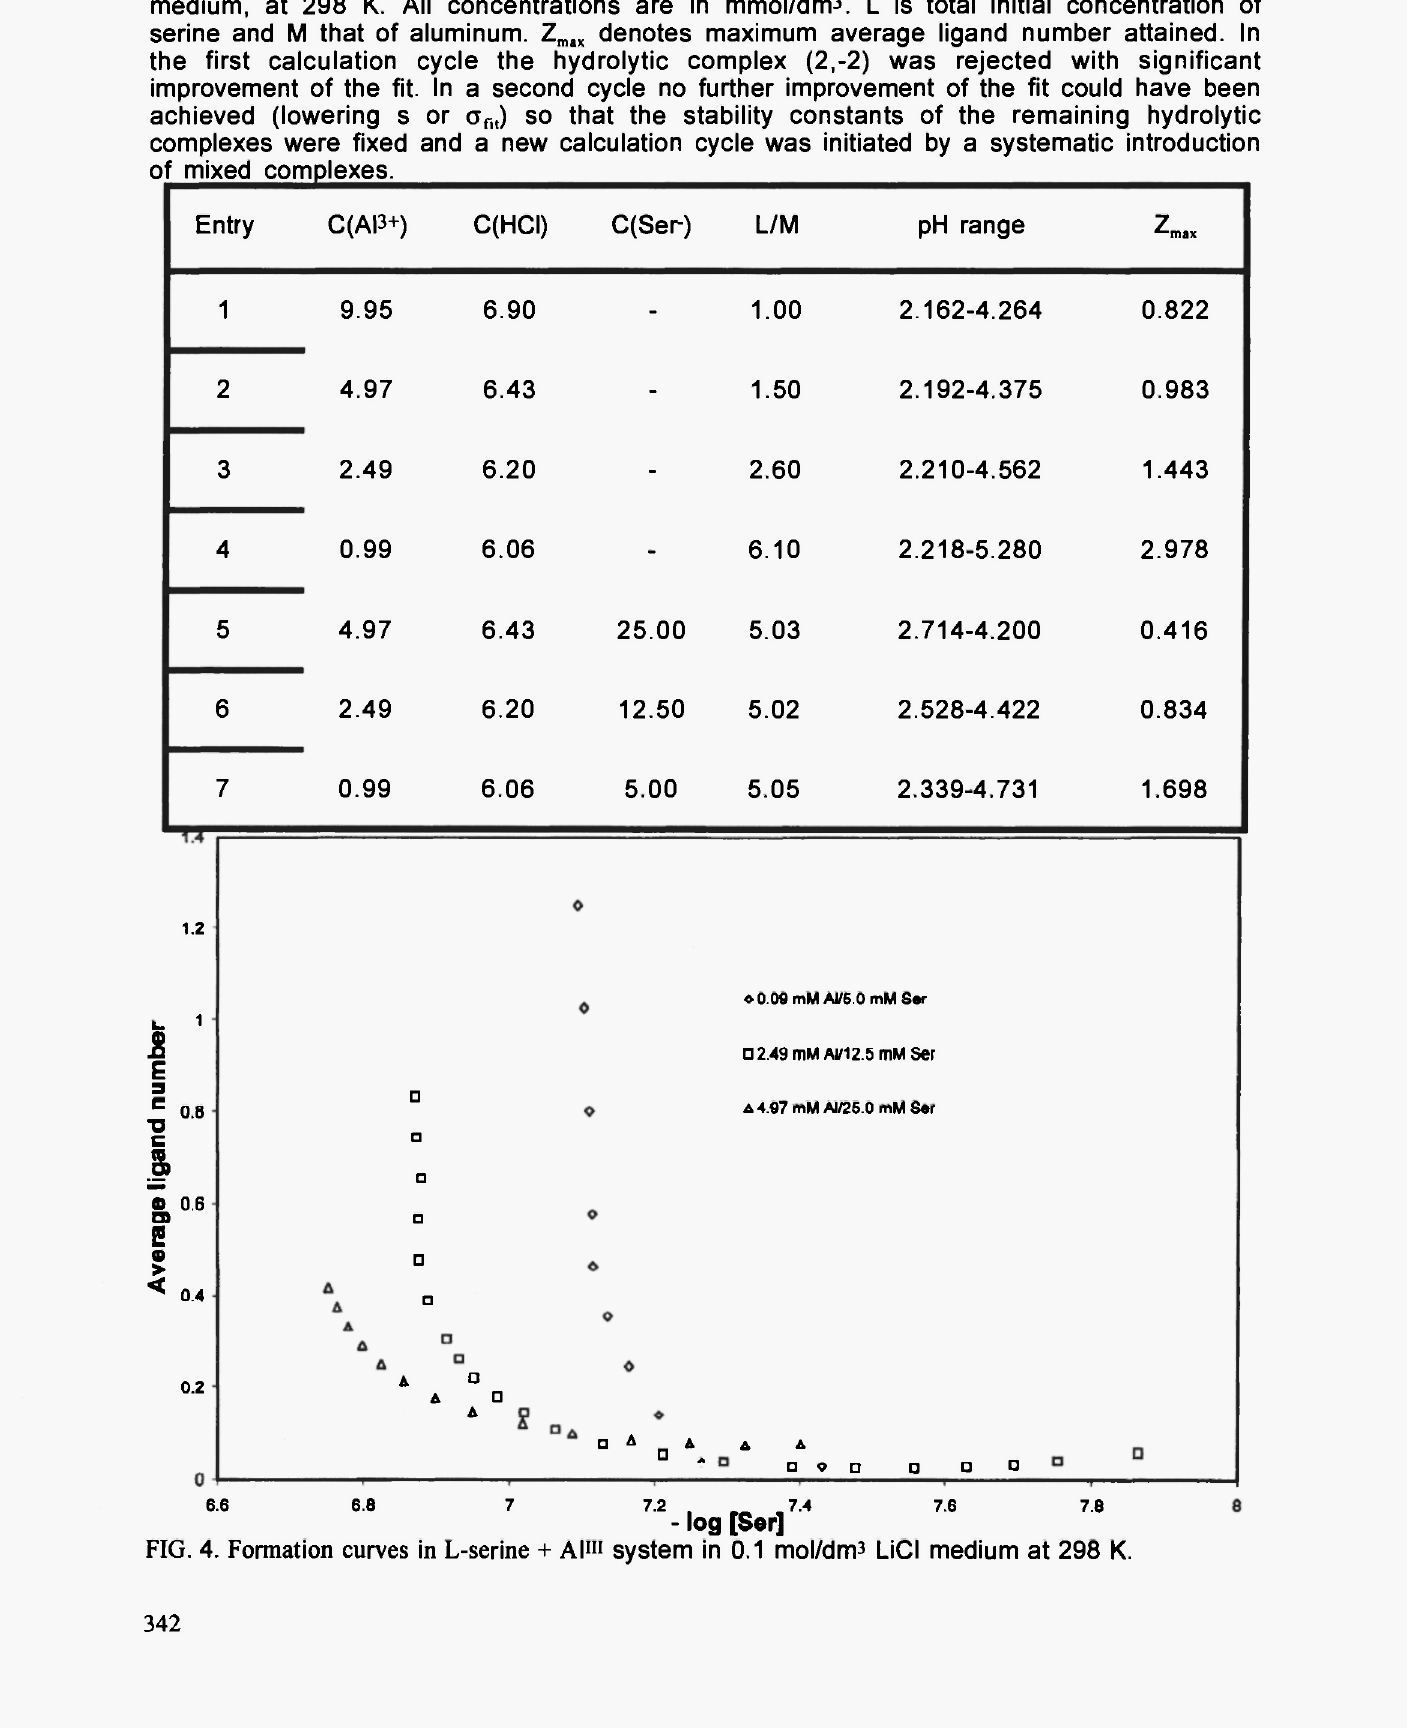
FIG. 4. Formation curves in L-serine + Al'" system in 0.1 mol/drrP LiCI medium at 298